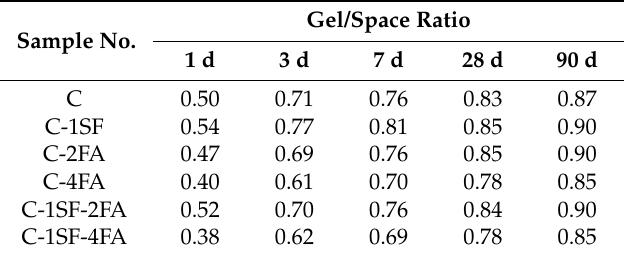
Table 4. Gel/space ratio of cement